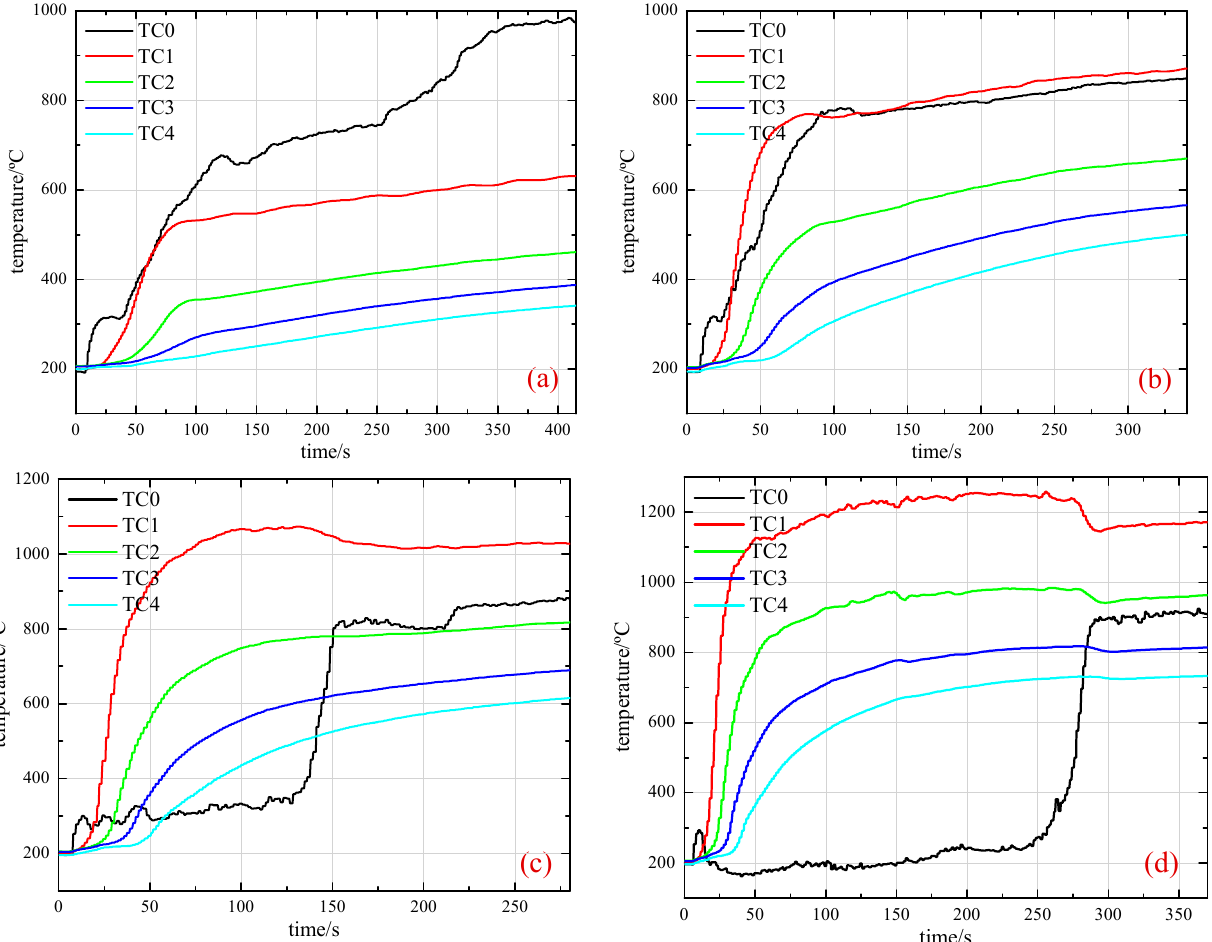
Figure 4. Temperature curves of the catalytic bed in a model thruster without the convergent nozzle at each flow rate: ( a ) 1 mL/min; ( b ) 2 mL/min; ( c ) 3 mL/min; ( d ) 4 mL/min. Table 2. Two rising stages of the temperature curves of the catalytic bed of a model thruster without the convergent nozzle at the flow rate of 1–4 mL/min. Flow